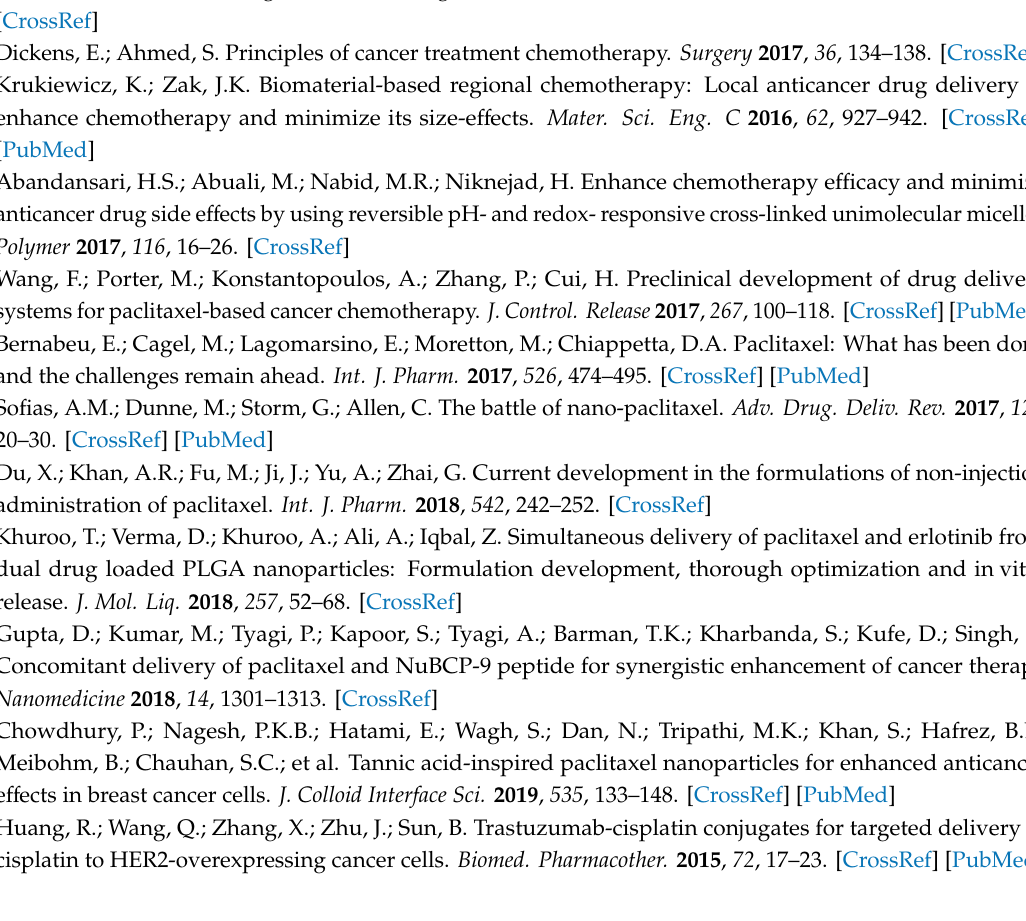
Figure S1: APPZ synthesis and characterization. Figure S2: Conjugated APPZ size and zeta potential determination at the conjugation-pH value. Figure S3: Results of the additional MTT experiments performed with the (a) BT474 and the (b) HS5 cell lines. They showed that conjugated APPZ specificity was favoured by trastuzumab conjugation and that PTX inclusion into β CD improved its aqueous solubility. Shown results are the mean ± SD of four replicas for each di ff erent